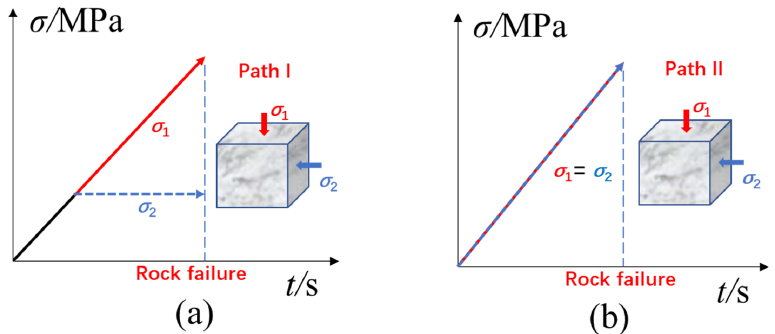
Figure 3. Stress loading paths, including ( a ) Path I and ( b ) Path II.